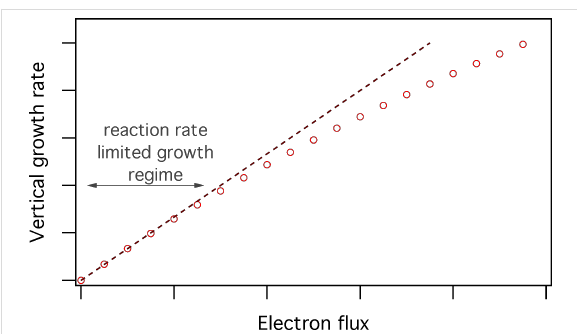
We note that Equation 2 describes non-activated